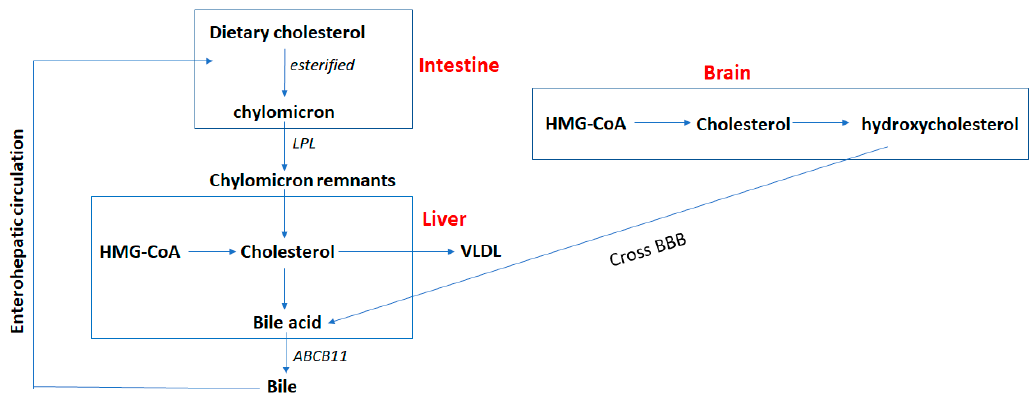
Figure 2. Cholesterol metabolism in liver vs. brain. The brain obtains cholesterol exclusively from de novo synthesis. On the contrary, hepatic cholesterol can be obtained by de novo synthesis and through dietary intake. Dietary cholesterol can be esterified and loaded into chylomicrons in the intestine. The chylomicrons are released into circulation and hydrolyzed by lipoprotein lipase (LPL) to form chylomicron remnants. Cholesterol left behind in the chylomicron remnants are taken up and utilized in the liver. The cholesterol synthesized in liver and from dietary origins can be packed into very low-density lipoprotein (VLDL) and exported from liver. Cholesterol can also be oxidized in the liver to form bile acids which excreted from liver into the bile via the ABCB11 transporter. Cholesterol in the brain can be hydrolyzed to form hydroxycholesterol which crosses the blood–brain barrier (BBB) and goes to the liver to be converted to bile acid. Cholesterol in the liver can be recycled through enterohepatic circulation, which does not exist in the brain. About 5% of the bile acids are lost in the feces, and the rest are reabsorbed into enterocytes.